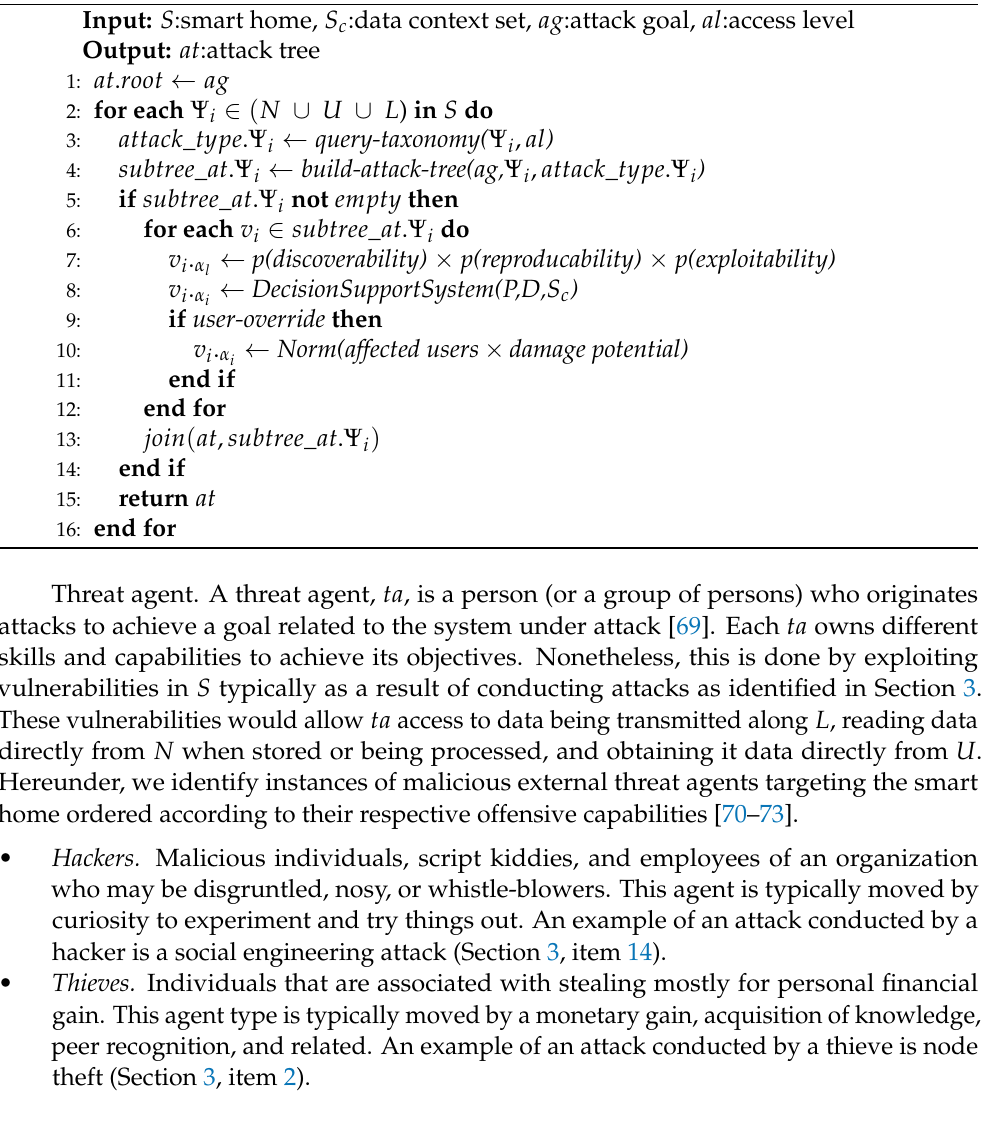
Algorithm 1 Computation of attack metrics for each